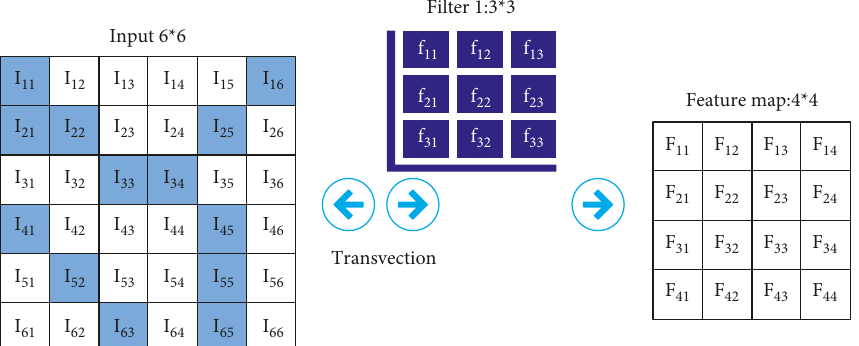
Figure 6: The convolution process of the convolution kernel.